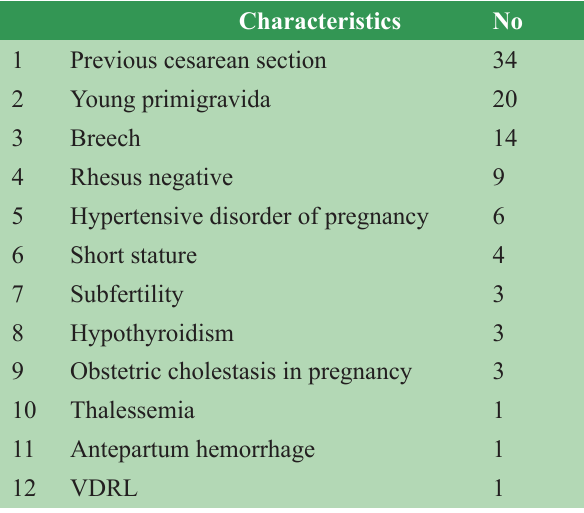
Table 1. Various type of high risk pregnancy (n=99).